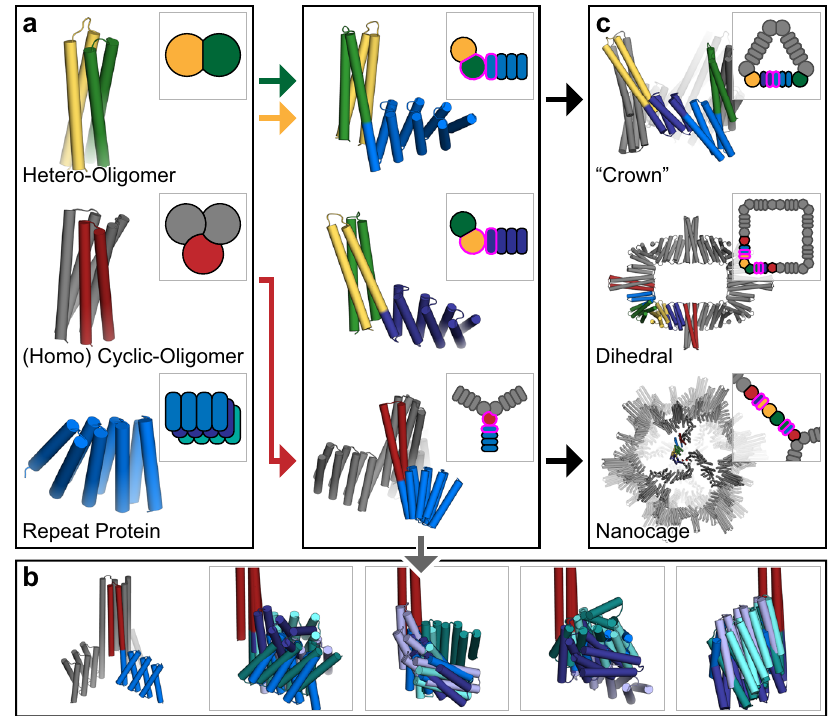
Fig. 1 Overview of the rigid hierarchical fusion approach. a Hetero- (yellow/green) and homo- (red) oligomeric helical bundles are fused to de novo helical repeat proteins (shades of blue) (left) to create a wide range of building blocks using HelixDock and HelixFuse (center). Symmetric units shown in gray. b Twenty representative HelixFuse outputs overlaid in groups of fi ve display the wide range of diversity that can be generated by using a single helical bundle core (symmetric units hidden for clarity). c Building blocks are further assembled into higher-ordered structures through helical fusion (WORMS). The examples are cyclic crowns (top), dihedral rings (middle), and icosahedral nanocages (bottom); additional details available in their respective sections.